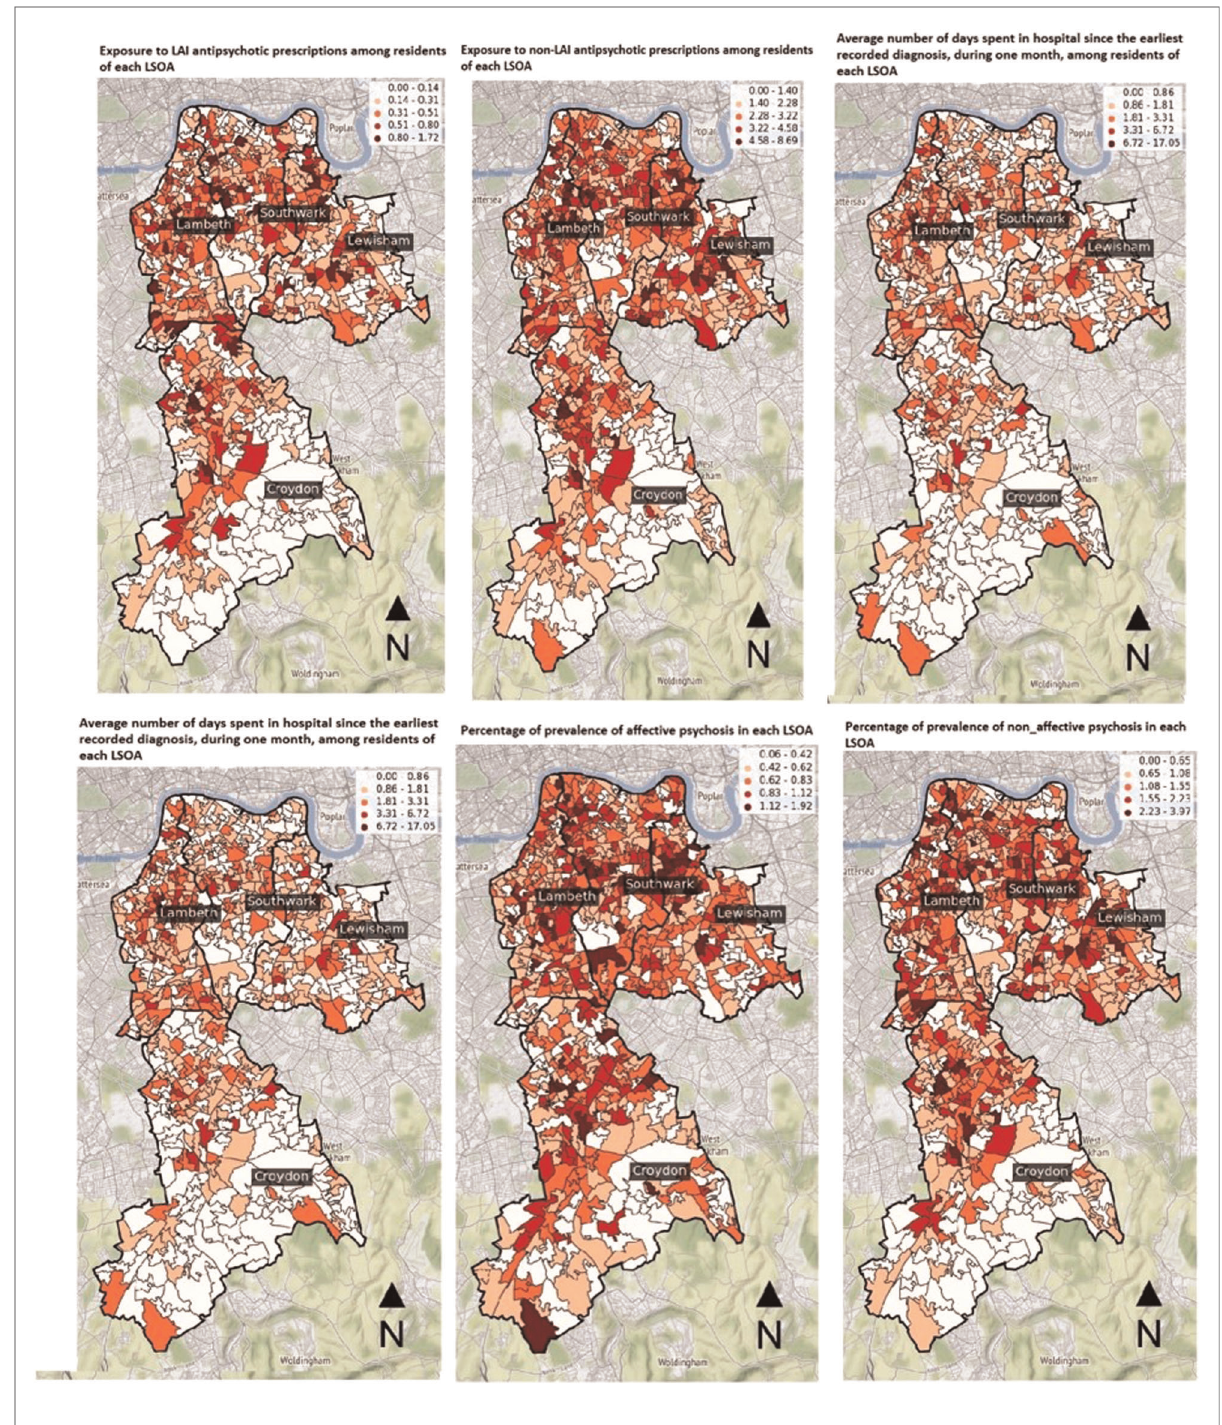
FIGURE 2 Visualising the distribution of clinical